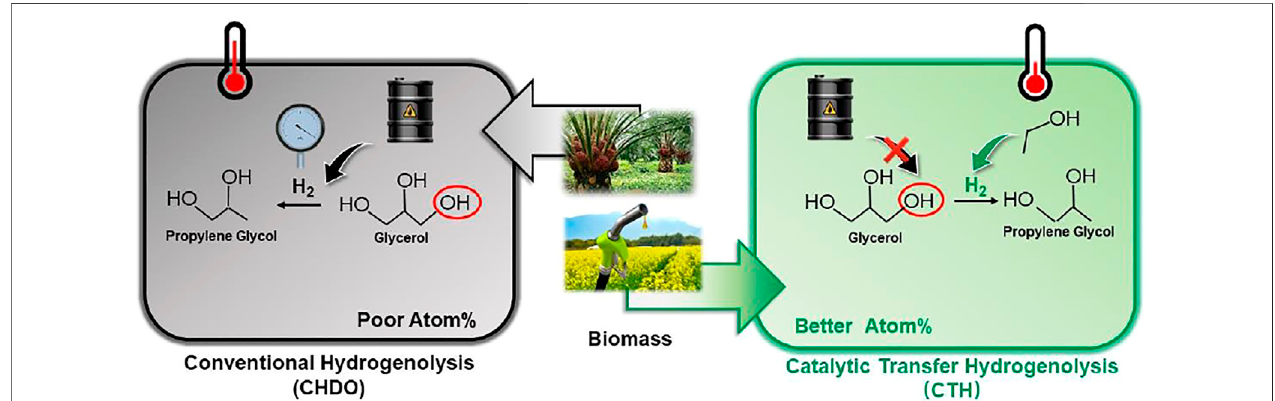
FIGURE 1 | Conventional HDO (CHDO) and catalytic transfer hydrogenolysis